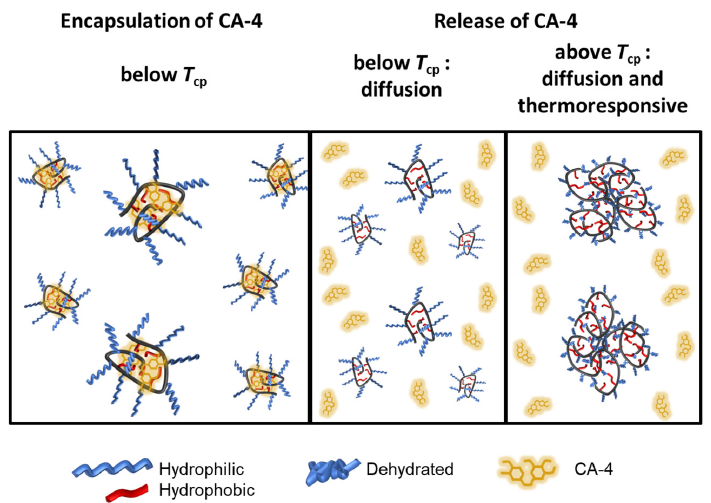
Figure 10. Release profiles of CA-4 from TEGMA- ran -FA with a 30/1 polymer/drug weight ratio at temperatures below and above T cp . As a reference, the release profile of CA-4 from a 1 g/L solution in DMSO is also shown.